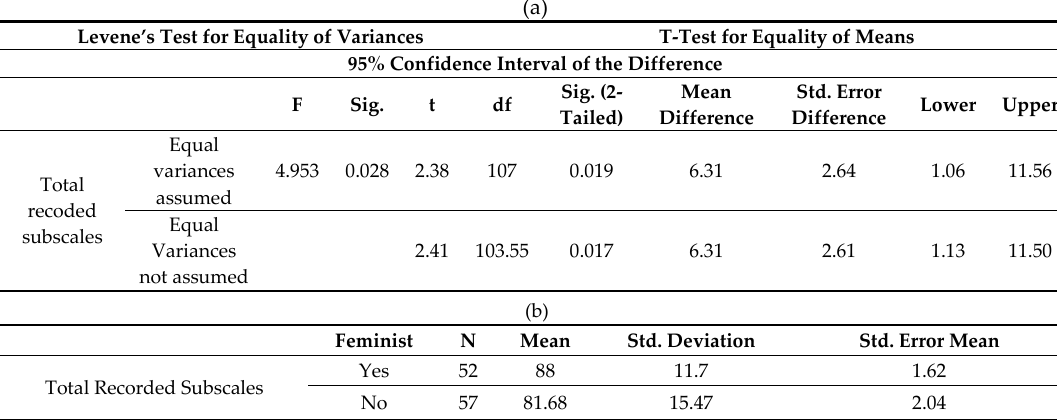
Table 5. Feminist Beliefs and Total IRMA Score: T-Test. (a)